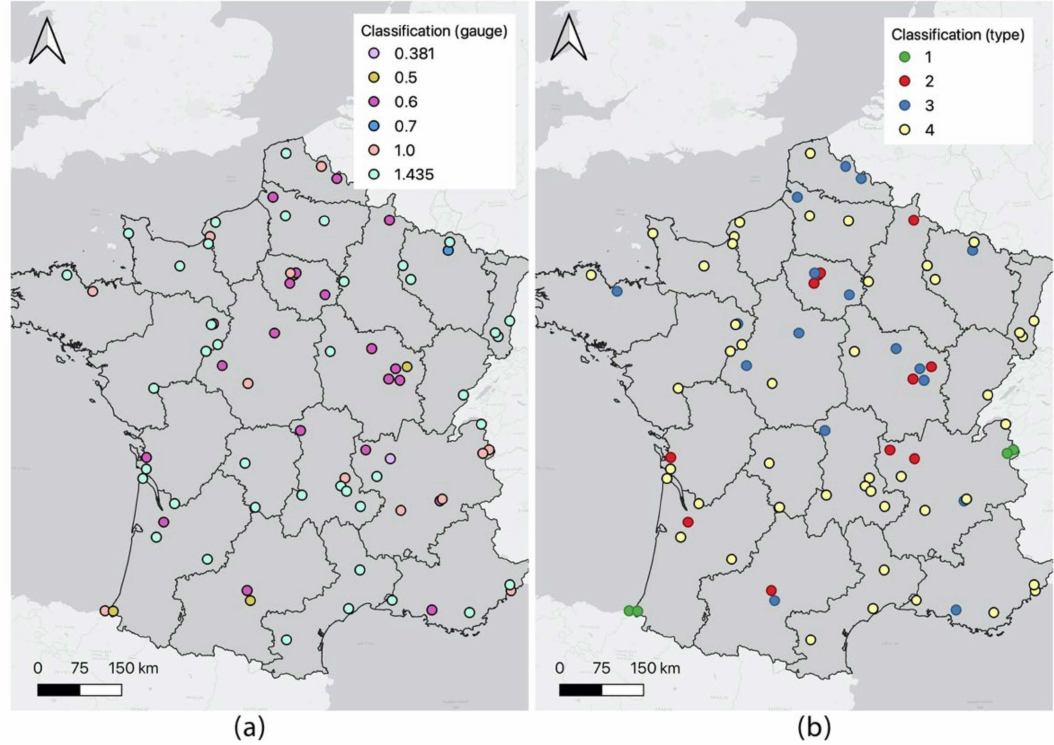
Figure 7. ( a ): Classification by railway types: (1) sightseeing trains; (2) entertainment trains; (3) railway museums; and (4) local railways. ( b ): Classification by the gauge of